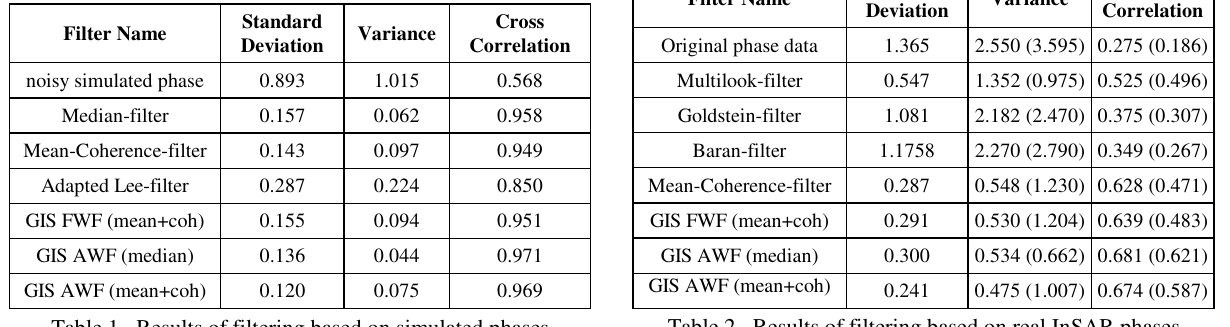
Table 1. Results of filtering based on simulated phases